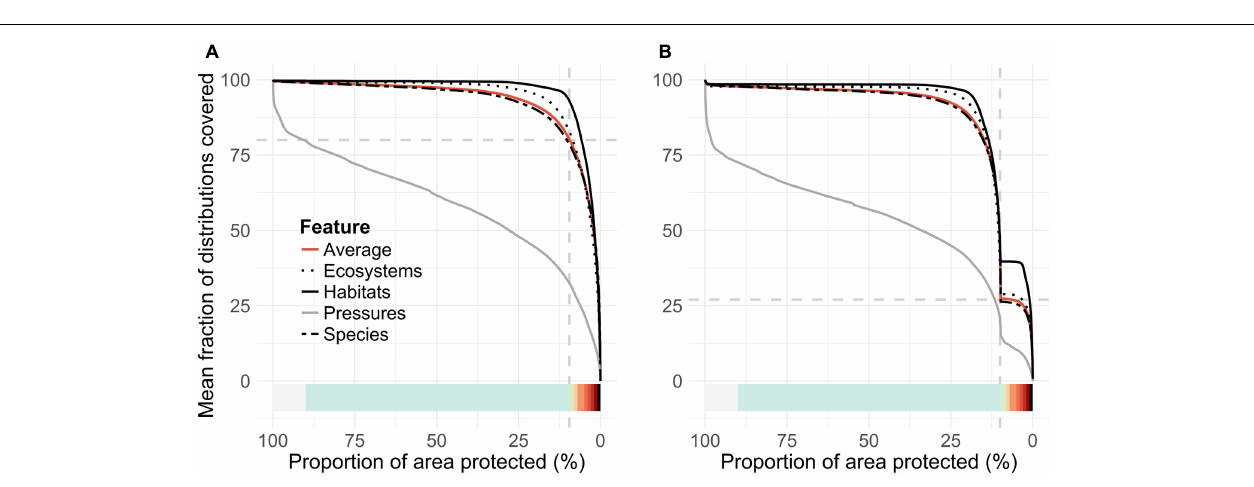
FIGURE 5 | Second standard output of a Zonation analysis, performance curves. (A,B) Pair with priority rank maps, Figures 4A,B , respectively, with matching color ramps. These curves summarize mean conservation coverage achieved across groups of features from the respective top-priority areas selected from the priority rank maps. The present MPA network (vertical dashed gray line in both panels) covers 27% (horizontal dashed gray line, B ) of the mean conservation coverage, compared to 80% (dashed gray line, A ) of the unconstrained Zonation